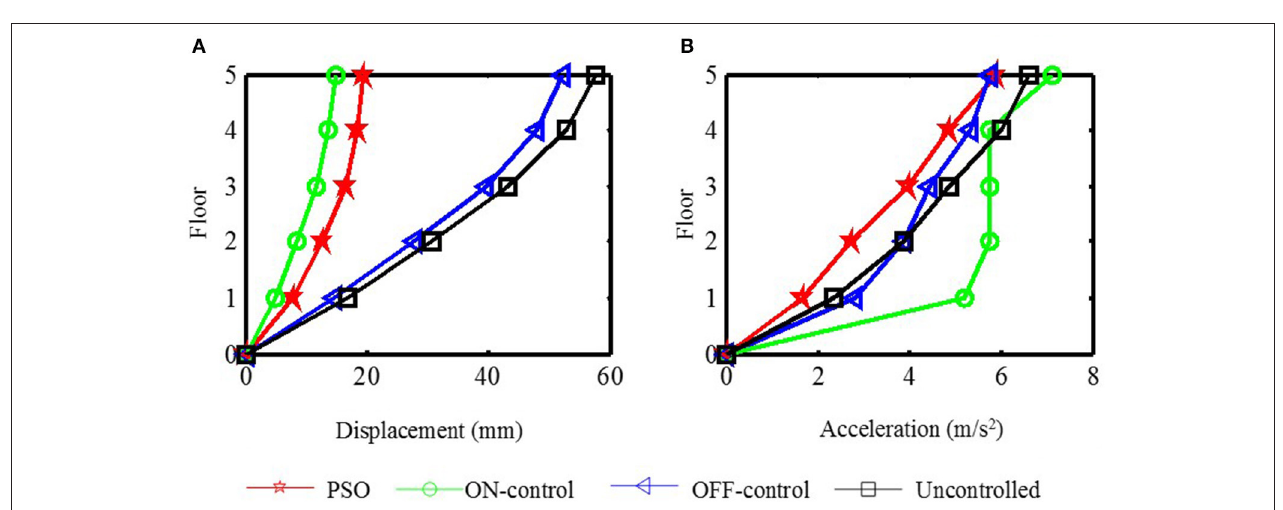
FIGURE 7 | The maximum response comparison of each floor under different control method (El-Centrol). (A) The maximum displacement response. (B) The maximum acceleration response. TABLE 1 | The maximum displacement responses comparison of each floor (El-Centro).